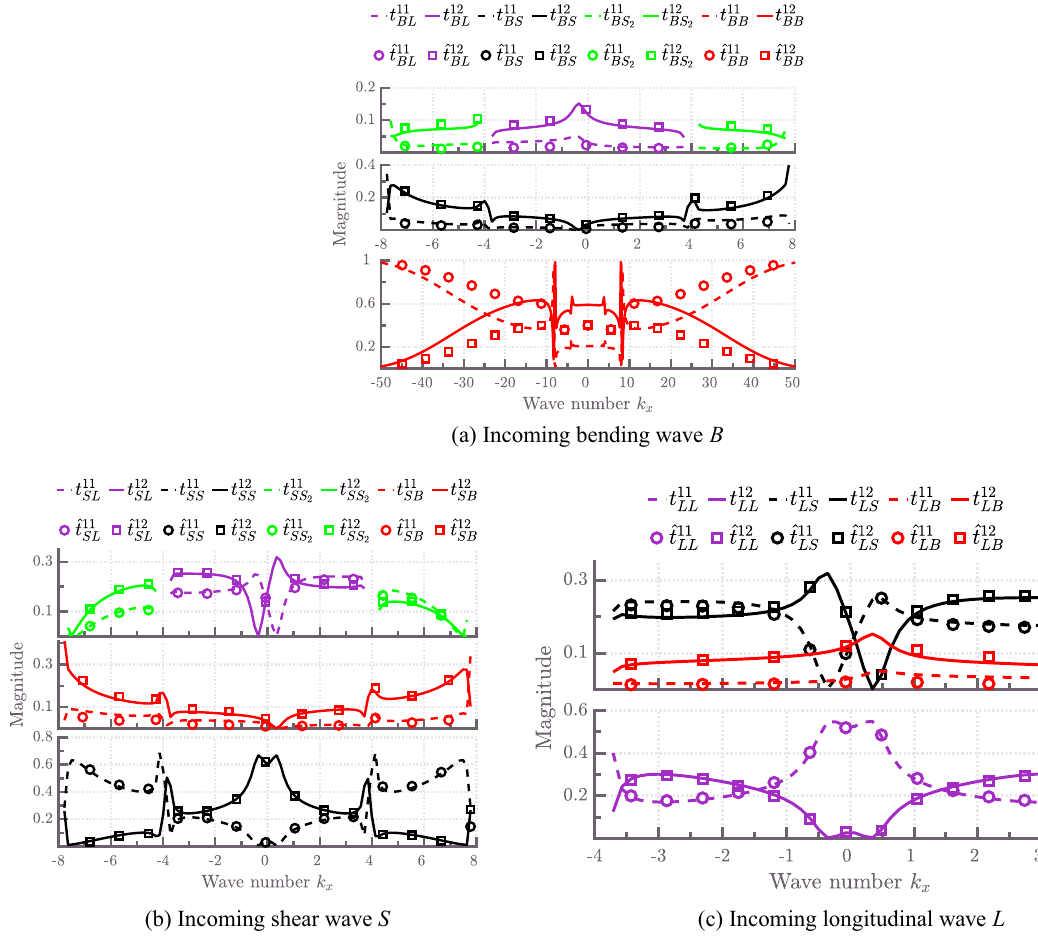
Figure 9. Energy scattering coefficients of an L-junction of two SOLID185-based angle-ply laminated plates for various incident waves plotted with respect to the wave number component k y at a frequency f = 3000 Hz. ˆ t nm ij denote semi-analytical scattering coefficients obtained using the method presented in 20